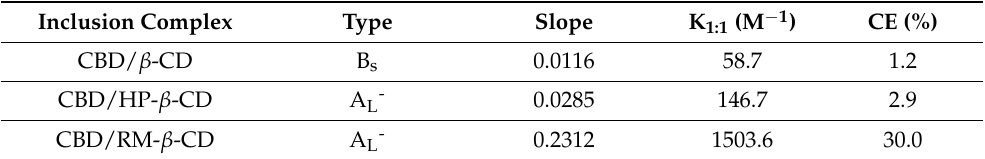
Table 2. Stability constants (K 1:1 ) and Complexation Efficiency (CE) calculations of CBD inclusion complexes with the native and two modified β -CDs at 25 ◦ C ( n =